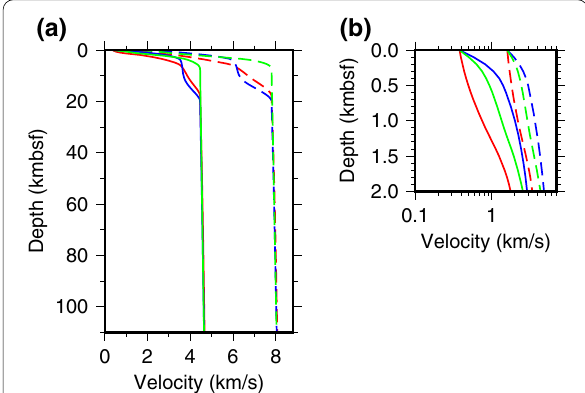
Fig. 4 Reference velocity models. Red, blue, and green lines represent the reference models for YMB3, JS4, and JPB4, respectively. Solid lines represent the S-wave velocity. Dashed lines represent the P-wave velocity. a Overall view. b Enlarged view for the shallow